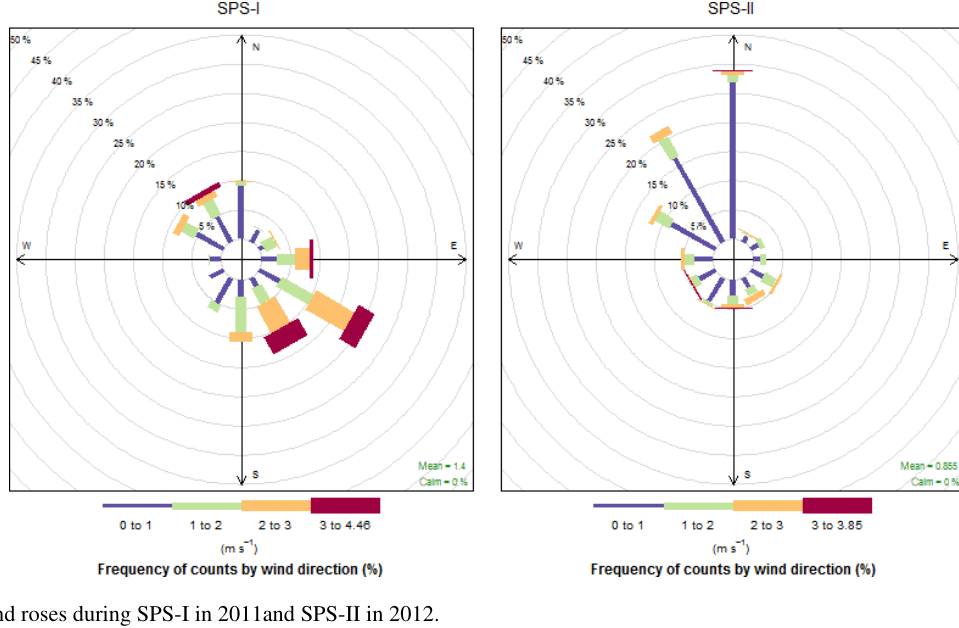
Figure 11. Wind roses during SPS-I in 2011and SPS-II in 2012.